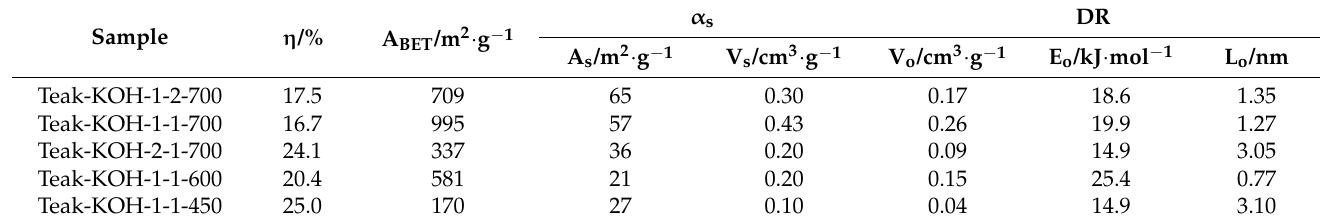
Table 1. Textural characteristics of ACs produced from Tectona Grandis sawdust, at different temper- atures, by chemical activation with KOH. In Tables 1 and 2, η is the AC production yield, A BET is the apparent surface area, V s is the volume total, A s is the external surface area (V s and A s were obtained using the alfa-s method [31]), V 0 is the volume of micropores, E o is the adsorption energy and L 0 is the mean pore size (V 0 , E 0 and L 0 were obtained using the Dubinin–Radushkevich equation [32].